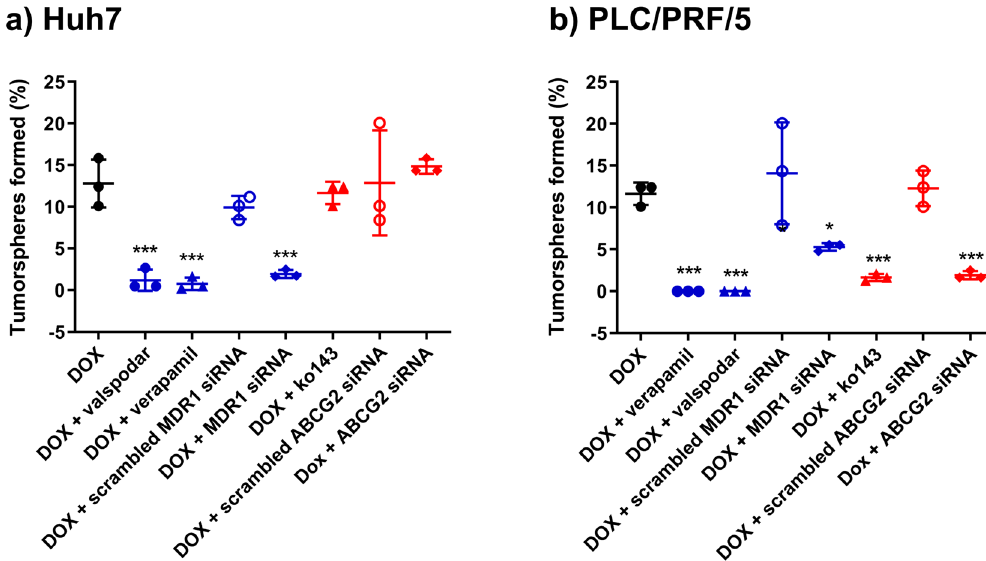
Figure 6. Effect of the inhibition of MDR1 and ABCG2 on the capability of doxorubicin (DOX) in the elimination of cancer stem cells in vitro. Huh7 or PLC/PRF/5 cells were treated with either doxorubicin (DOX) alone or treated with inhibitors or siRNA to MDR1 or ABCG2 first, followed by DOX treatment as described in “Materials and methods” section. Cells were then plated in ultra-low attachment plates at a density of 10, 20, or 50 cells/well and incubated for 7 days under the condition of in vitro limiting dilution assay to assess the self- renewal capacity of treated cells. The frequency of tumorsphere-forming cells for Huh7 ( a ) or PLC/PRF/5 cells ( b ) under indicated treatment is shown. Data presented are mean ± SD, n = 3. * p < 0.05; *** p <